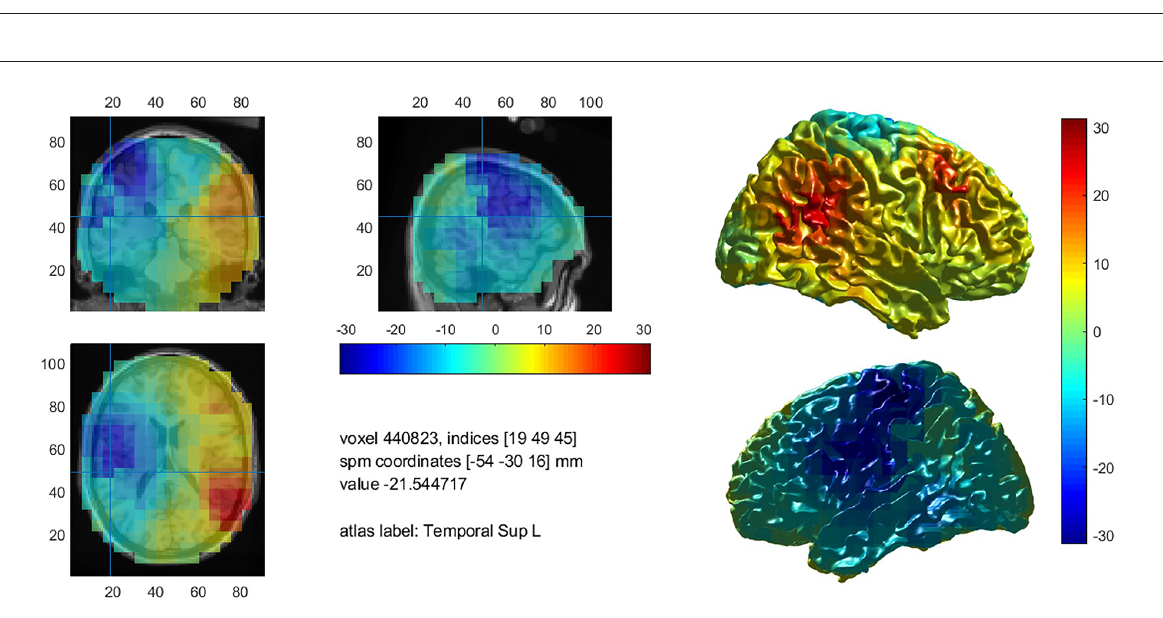
10% of activation. Further reports are limited to the former, non-individualized activation